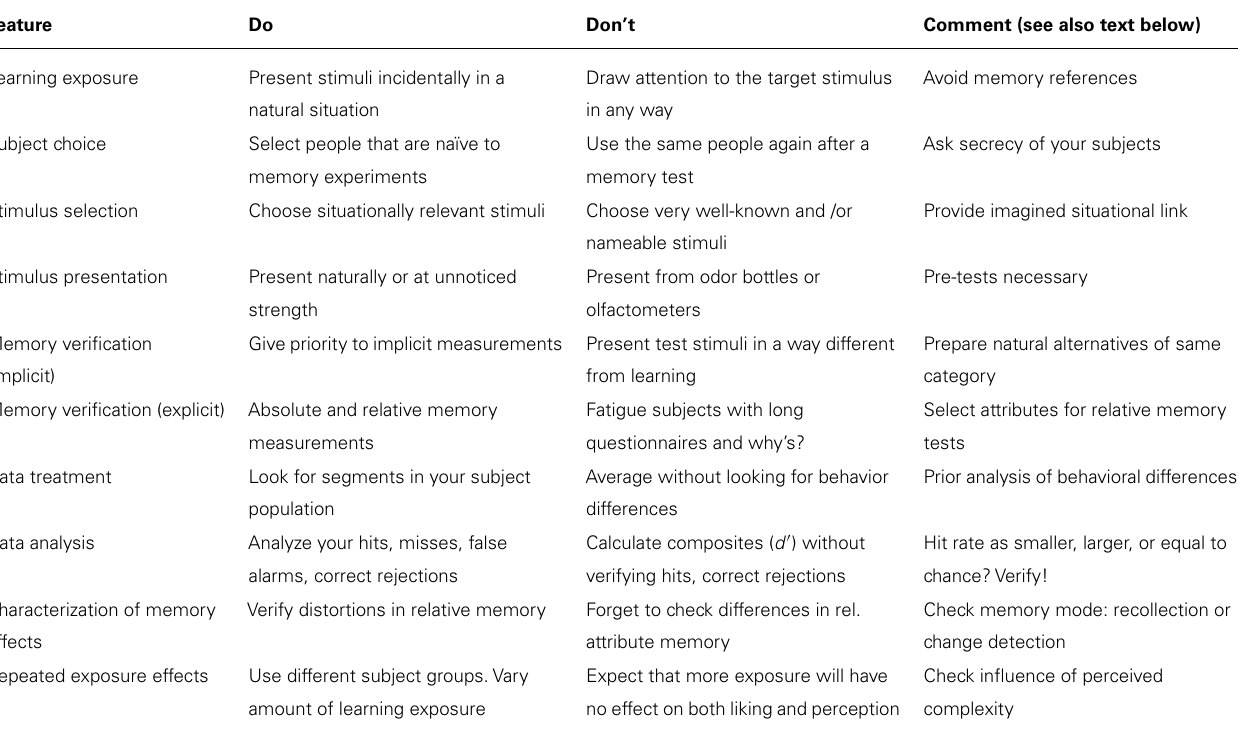
Table 2 | Overview of recommendations in ecologically valid odor memory research.